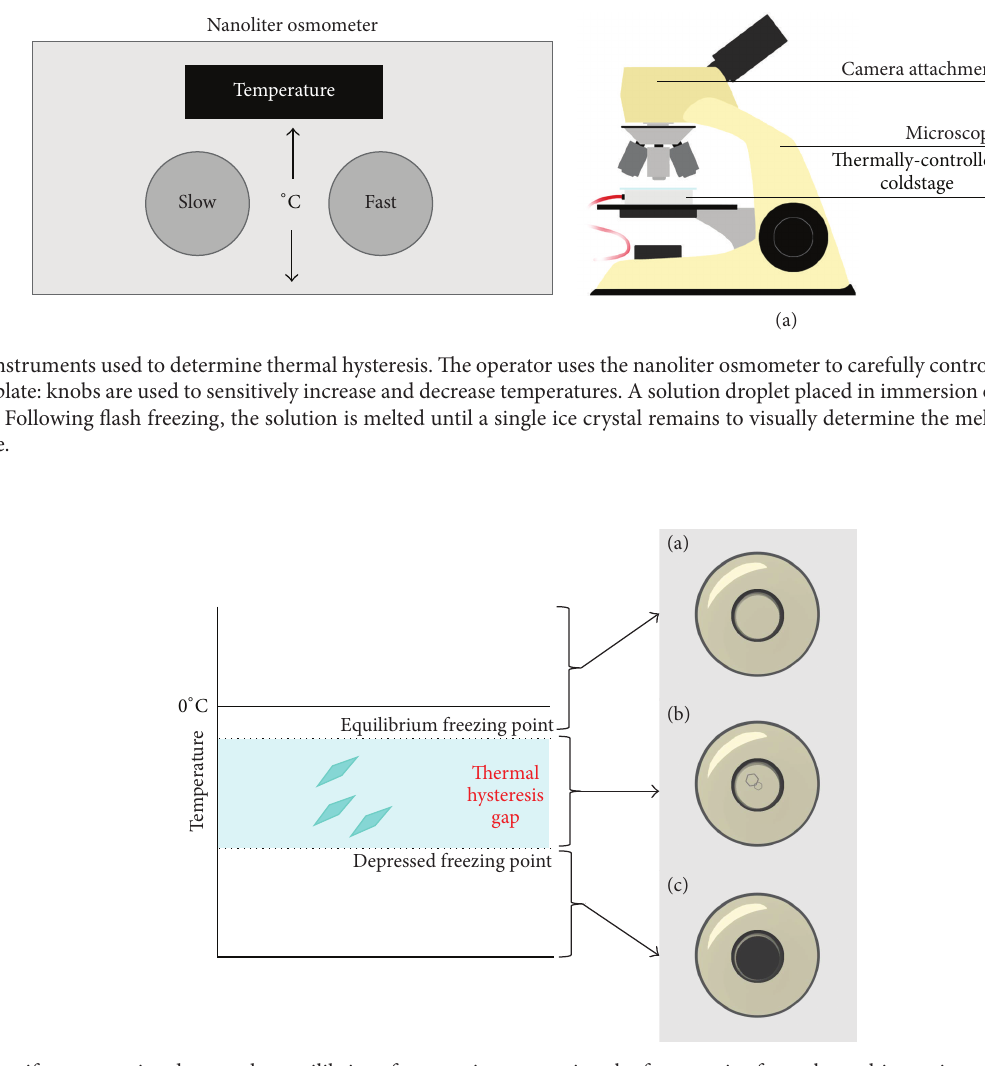
Figure 4: Antifreeze proteins depress the equilibrium freeze point, separating the freeze point from the melting point, creating a thermal hysteresis gap. In this gap, continual ice growth is inhibited and preventing freezing of the organism. Beyond this gap, freezing is inevitable. This can be observed with the nanoliter osmometer (a)–(c). (a) Above the equilibrium freeze/melting point ice crystals are absent. (b) After isolatingindividualicecrystals,withinthegapicecrystalsareseentoneithergrownormelt.(c)Beyondthegap,explosivegrowthofnumerous ice crystals increases the opacity of the droplet, blocking microscope